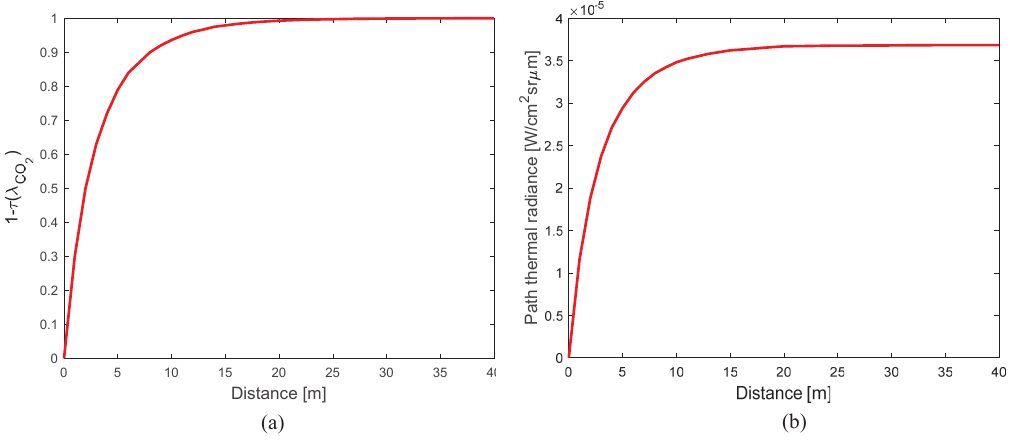
Figure 14. ( a ) (1-atmospheric transmittance) vs. distance (MODTRAN-based simulation at CO 2 absorption band (4.29 µ m)), ( b ) path thermal radiance vs. distance (MODTRAN-based